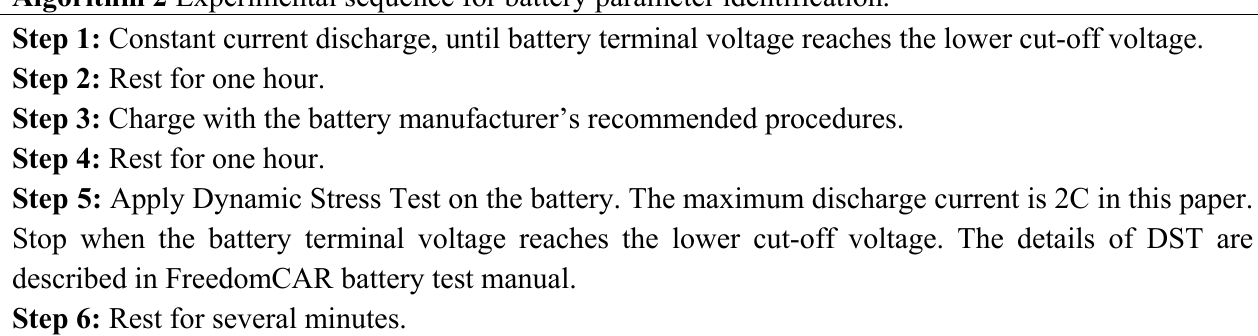
Algorithm 2 Experimental sequence for battery parameter identification.